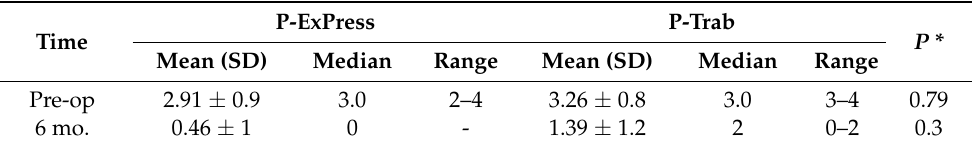
Table 3. Number of hypotensive drugs: mean values, median values, standard deviations, and ranges in the phaco-Ex-Press (P-ExPress) and phaco-trabeculectomy (P-Trab) groups before and 6 months after surgery.